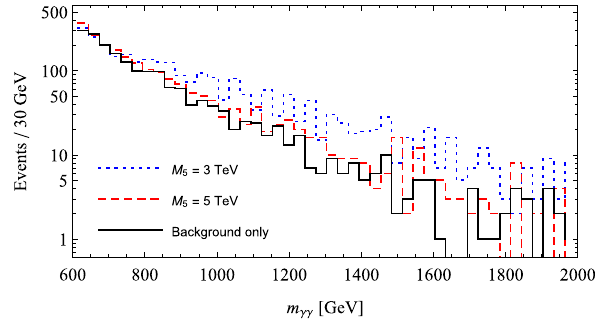
Fig. 3 Mass spectra leading to the scalograms of Fig. 2. The black (solid), blue (dotted) and red (dashed) lines correspond to b , e and f ,